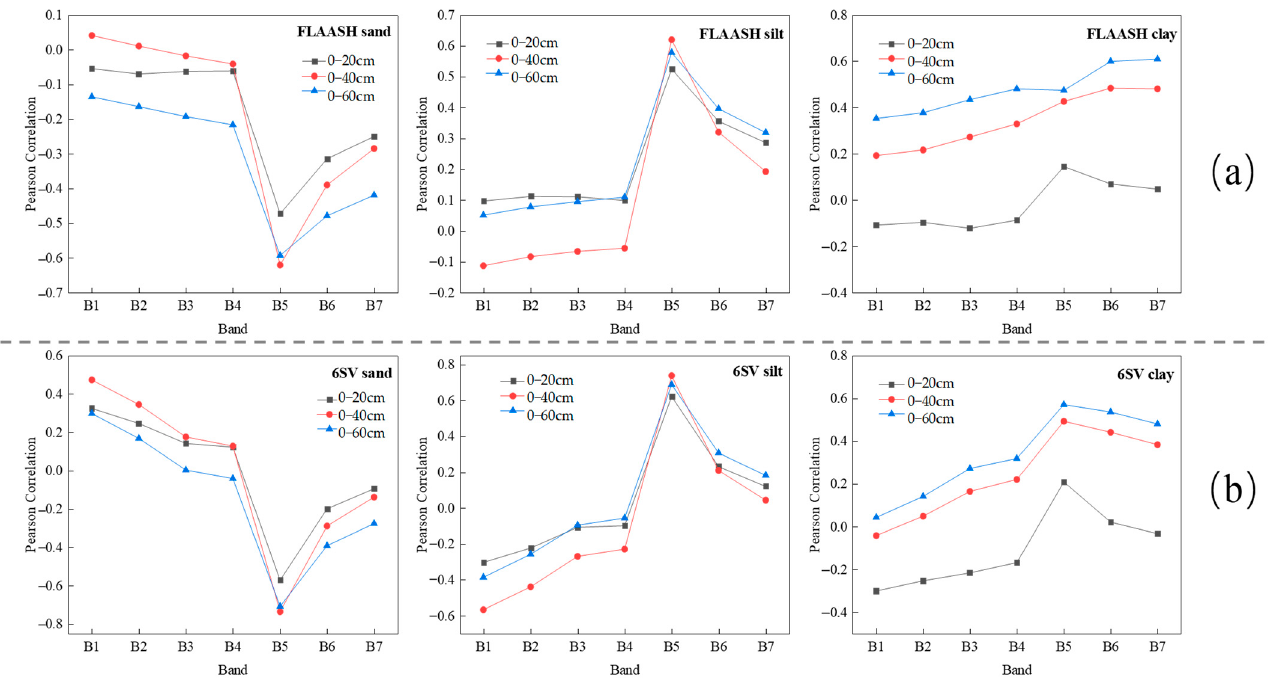
Figure 7. Correlation between soil particle-size content in different thickness and reflectance spectra of ( a ) FLAASH atmospheric correction model and ( b ) 6SV atmospheric correction model.